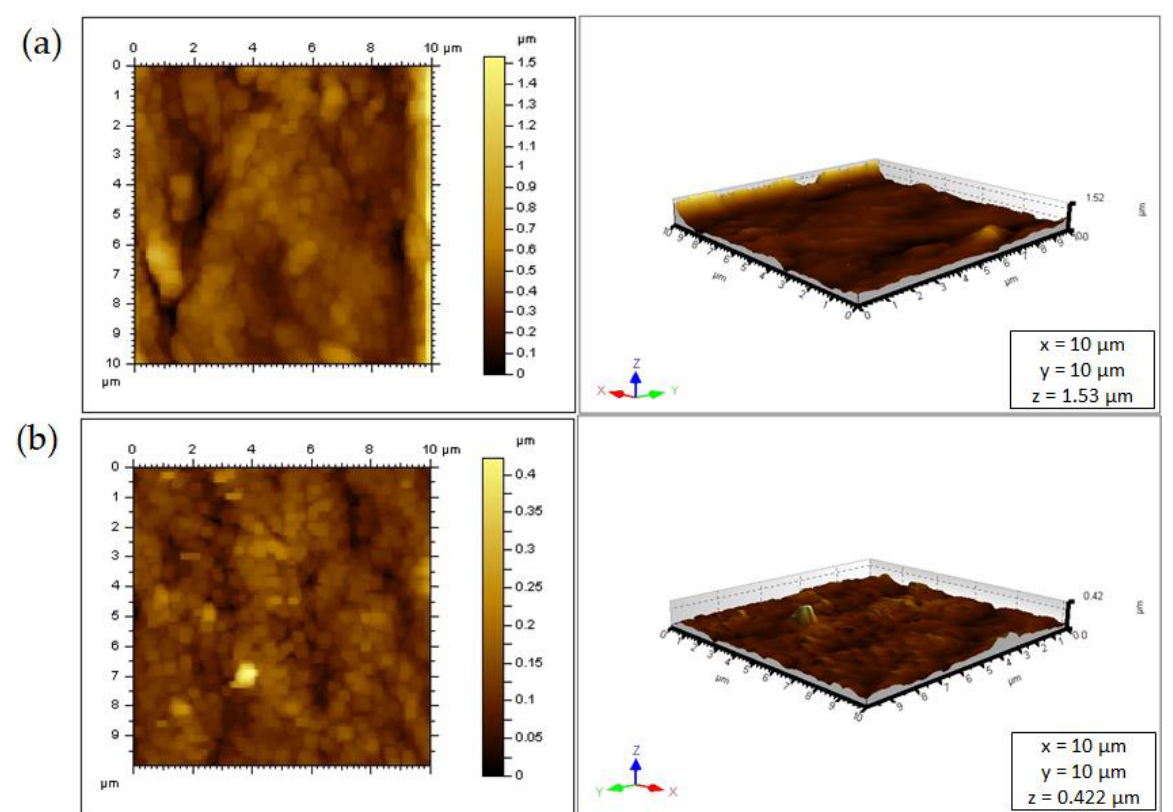
Figure 6. AFM micrographs of ( a ) PVDF and ( b ) HA-MWCNT membranes. The left and right images represent the 2D and the 3D topographies, respectively.